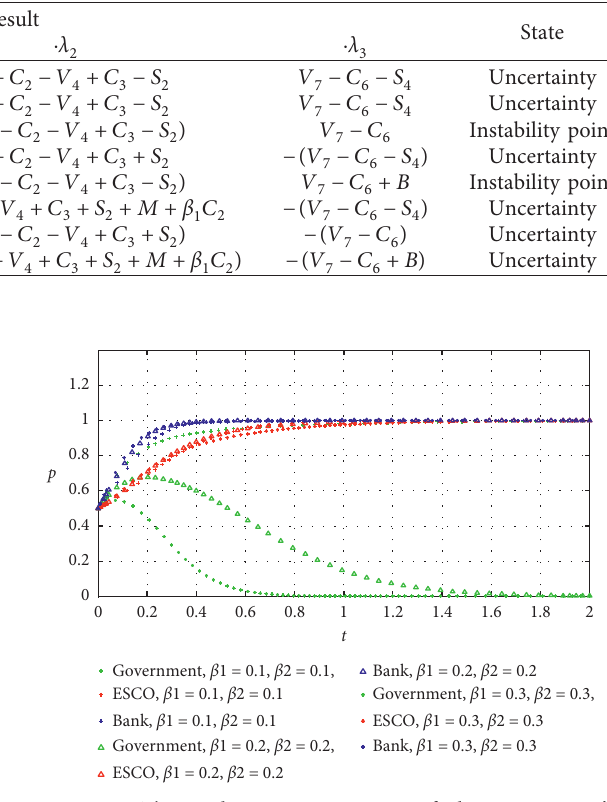
Figure 10: The evolutionary trajectory of the government’s, ESCOs’, and banks’ behaviors under different β